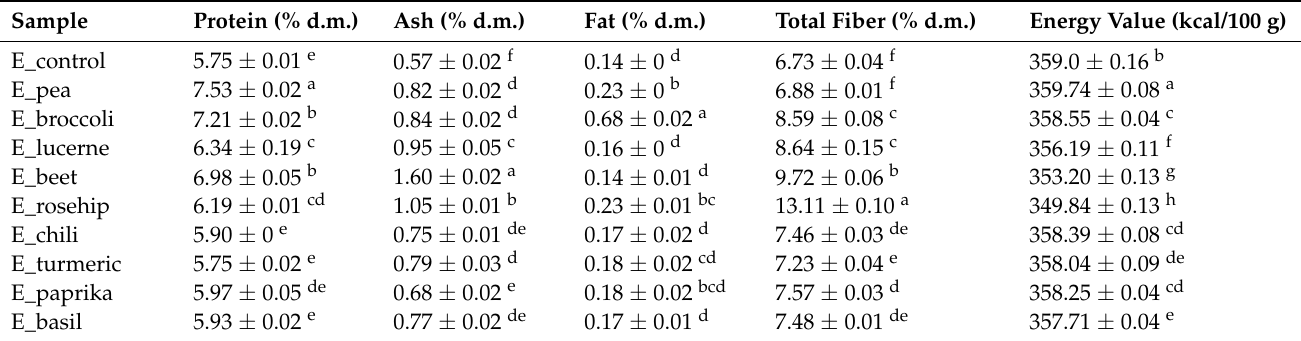
Table 1. Proximate composition of the different types of corn-based